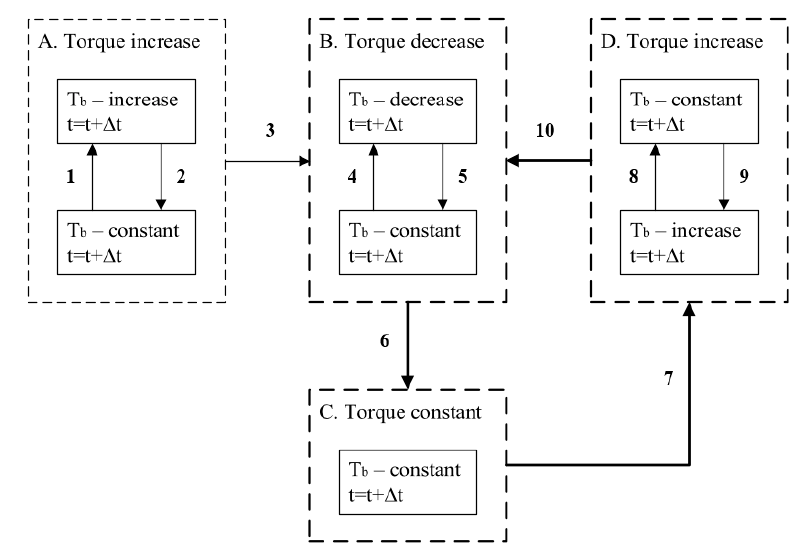
Figure A1. ABS Figure A1. ABS algorithm.